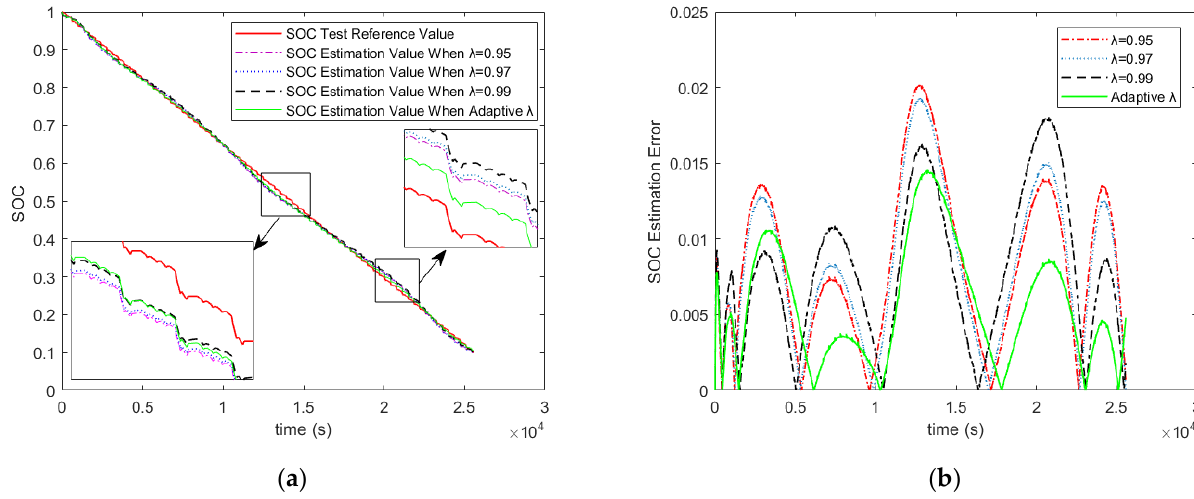
Figure 7. SOC estimation results and error comparison: ( a ) Comparison of SOC estimation results, ( b ) SOC estimation error absolute value comparison.